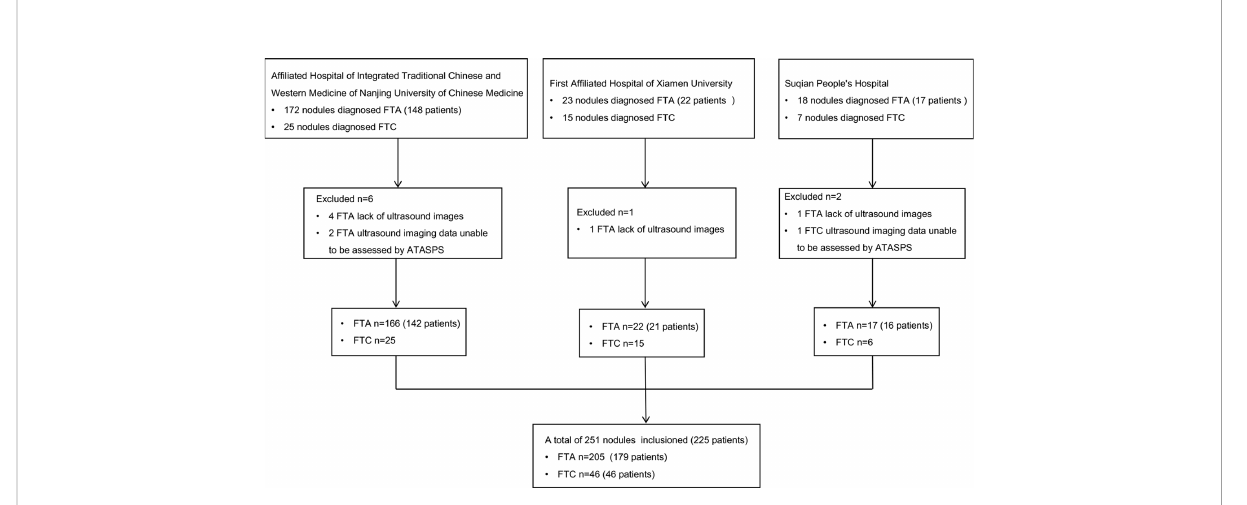
FIGURE 1 Flowchart summarizing the patient inclusion